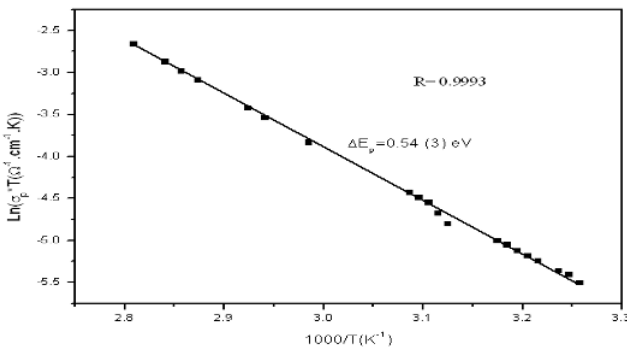
Fig.8. Variation of Ln ( σ p .T) versus (1000/T) of C 2 H 10 N 2 Cd(SCN) 2 (Cl)